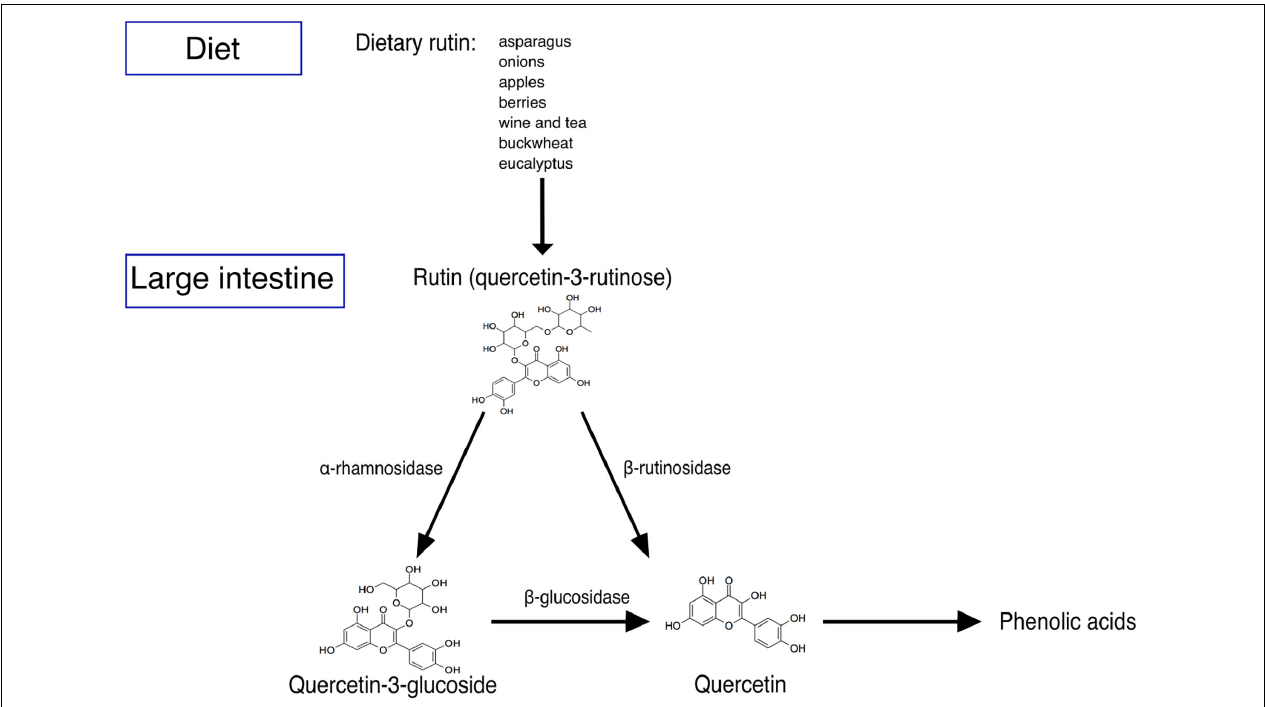
FIGURE 1 | Schematic representation of rutin degradation. Rutin is present in a wide variety of foods. Rutin is not well absorbed in the small intestine of humans, and thus is transported into the colon and metabolized by the gut microbiota into quercetin-3-glucoside and then quercetin or directly into quercetin. Quercetin may be subsequently degraded mainly into different phenolic